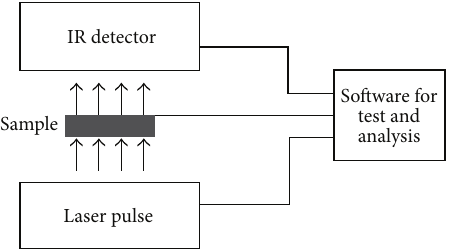
Figure 5: Illustration of laser flash analysis technique.